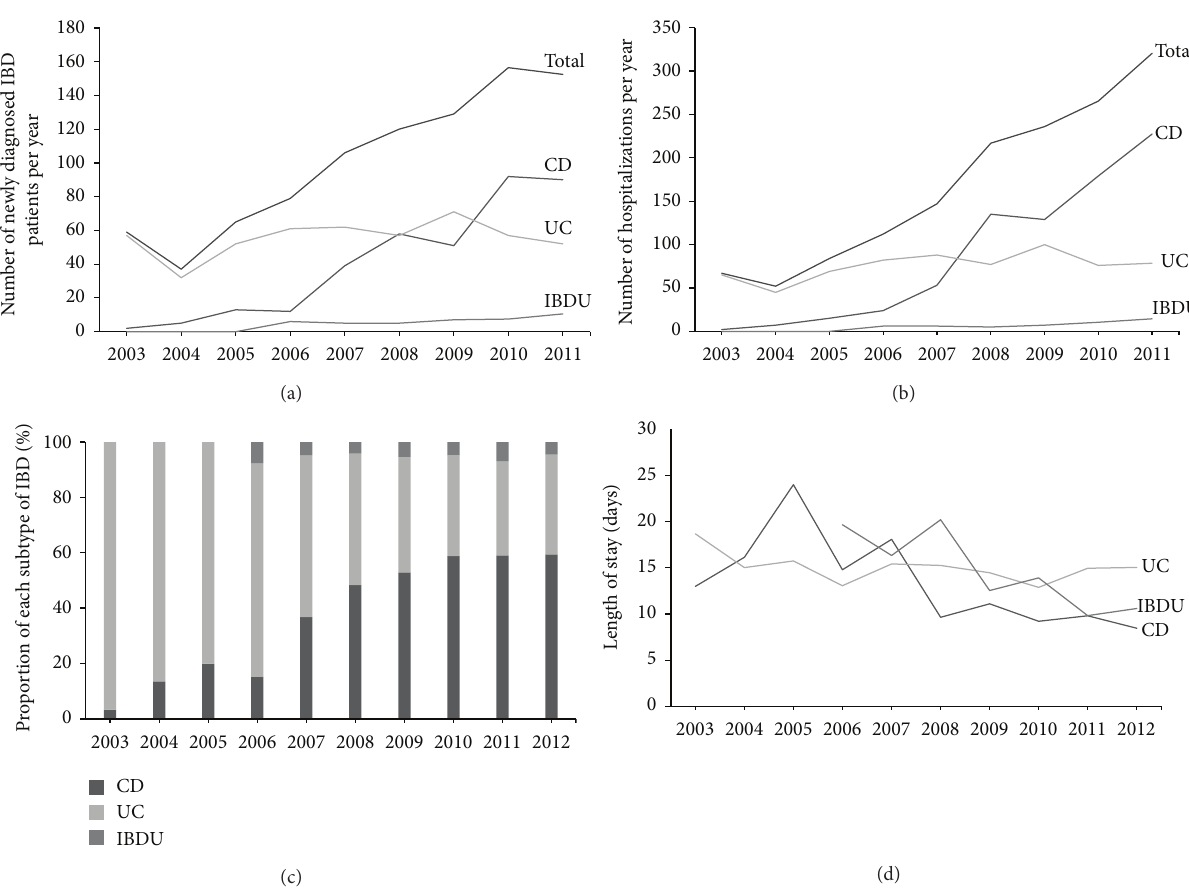
Figure 1: Growing population of IBD patients and hospitalizations. (a) Number of newly diagnosed patients with IBD per year. CD patients increased more significantly ( 𝑅 2 = 0.916 , 𝑃 < 0.001 ); (b) number of hospitalizations per year, number of hospitalizations increased more significantly in CD patients ( 𝑅 2 = 0.937 , 𝑃 < 0.001 ); (c) proportion of each subtype of IBD changed from 2003 to 2011. Population data of IBD patients and hospitalizations were collected from Renji hospital between Jan, 2003 and Dec, 2011 and from Ruijin hospital between Jan, 2010 and Dec, 2011. Proportion data of IBD patients were collected from Renji hospital between Jan, 2003 and May, 2012 and Ruijin hospital from Aug, 2009 and Jun, 2012. (d) The trend of length of stay.